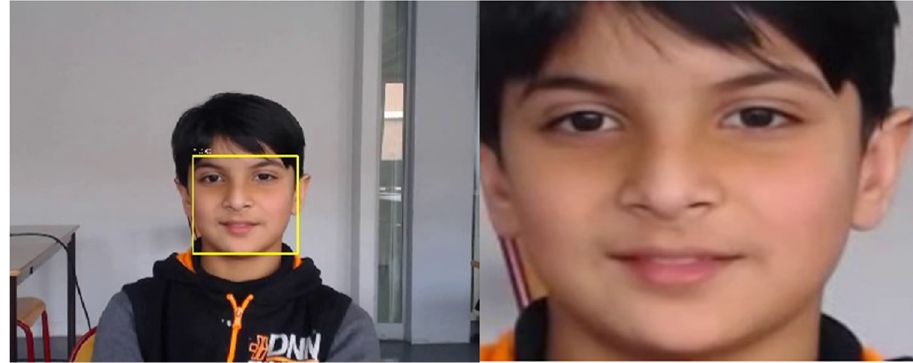
Figure 5. YOLOv3 simultaneous face detection and cropping.